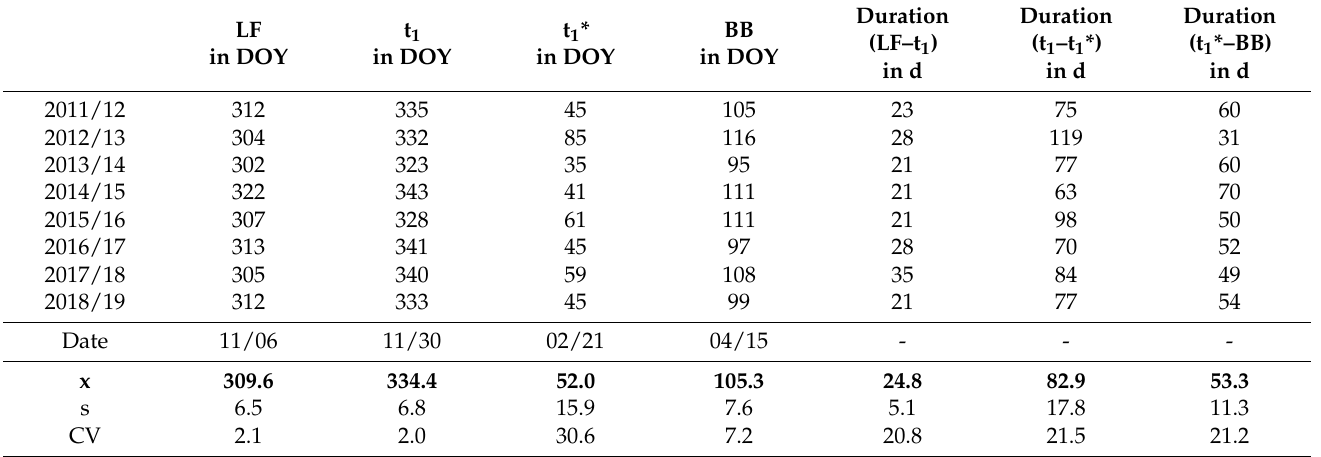
Table 1. Timing of ‘total leaf fall’ (LF), endodormancy release (t 1 ), beginning of ontogenetic develop- ment (t 1 *), beginning of blossom (BB) and duration of endo- (LF–t 1 ), ecodormancy phase (t 1 –t 1 *) and